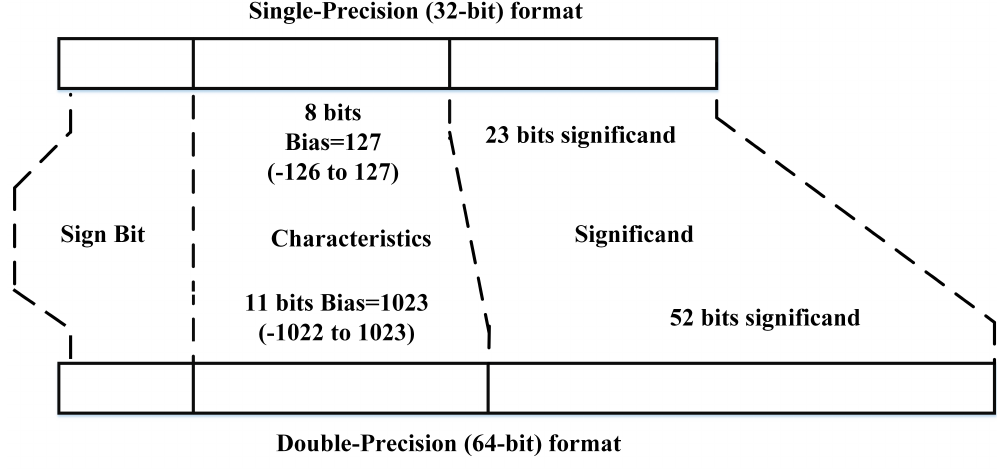
Figure 3. Floating-point representation